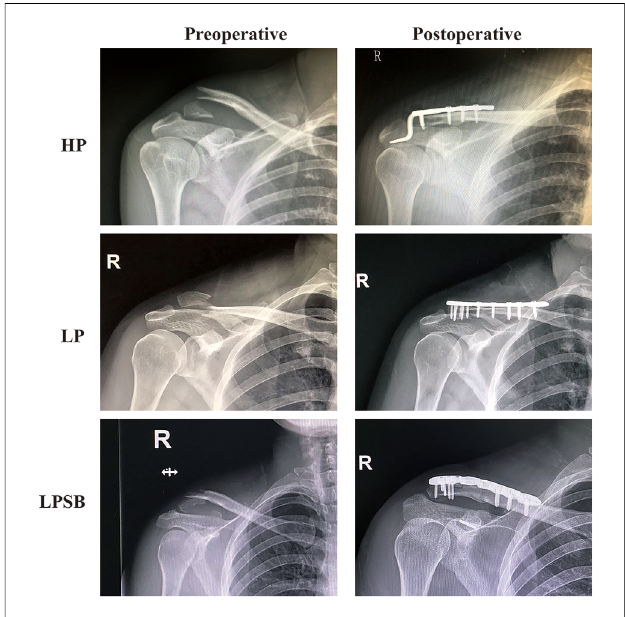
FIGURE 2 Preoperative and postoperative x-ray images in HP group, LP group, and LPSB group. HP, hook plate; LP, locking plate; LPSB, locking plate with a suture